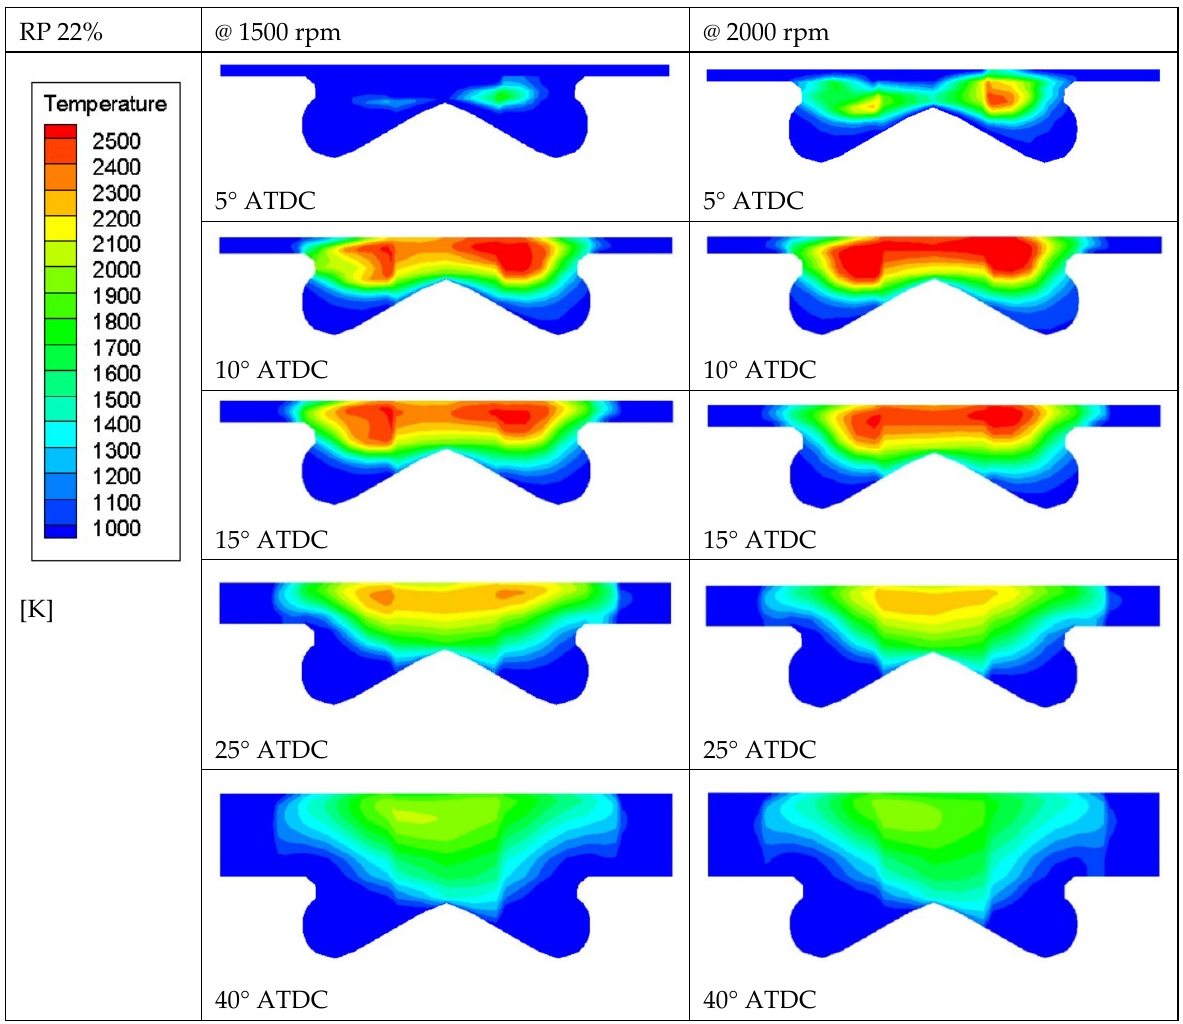
Figure 6. Temperature distributions in RP = 22 @1500 and 2000rpm cases.